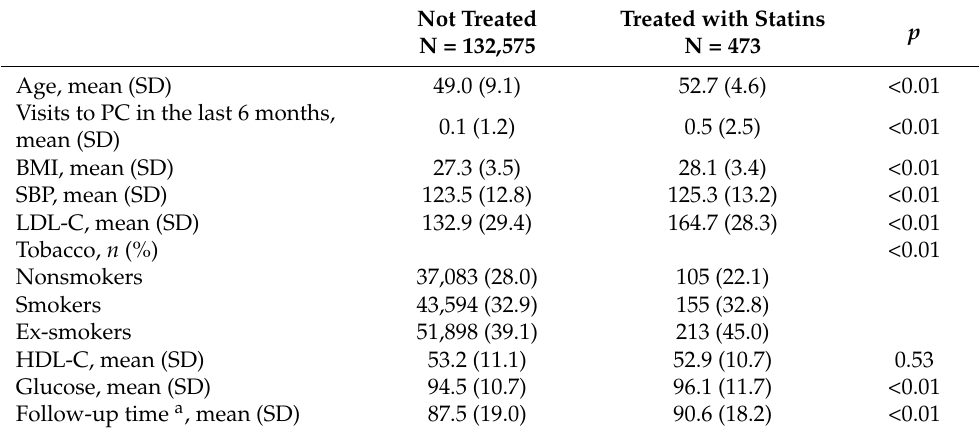
Table 1. Characteristics of the total subject-trials selected for the study.